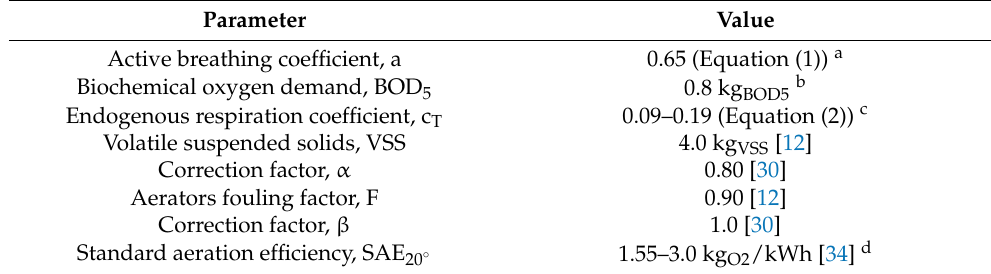
Table 1. Data used for the